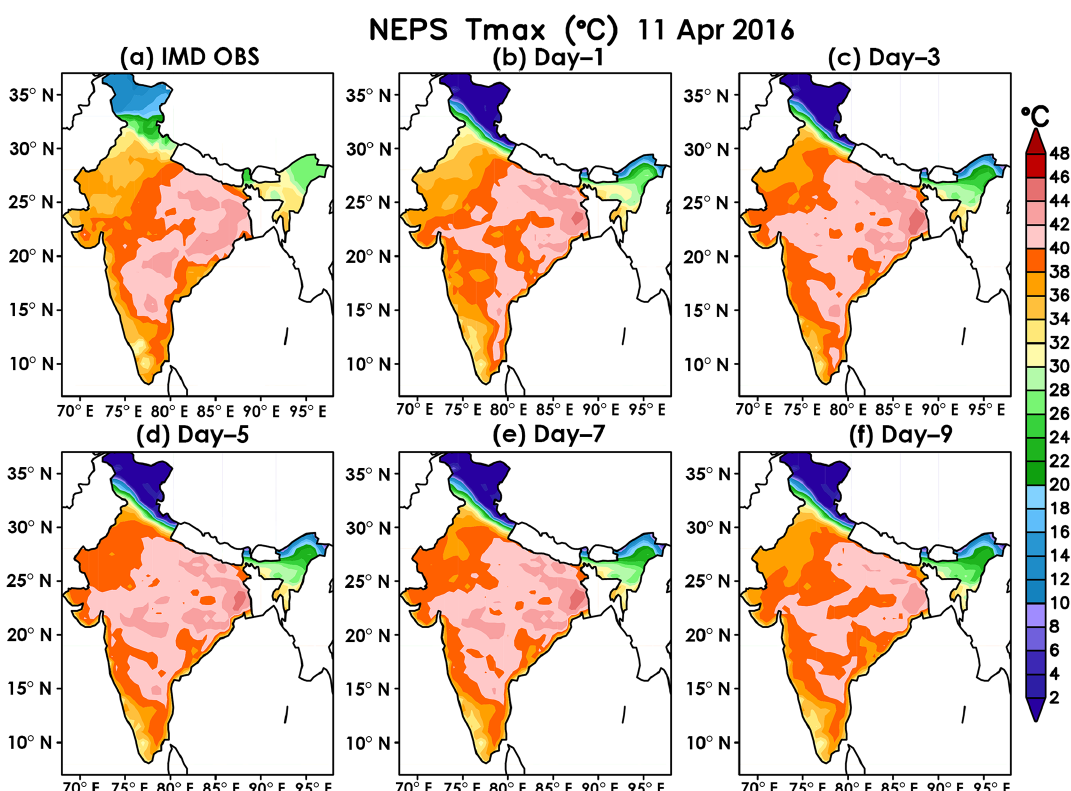
Figure 6. Spatial distributions of observed T max (a) and NEPS forecast T max (b–f) prevailing heatwaves over MP, Odisha, AP, Telangana and some parts of Maharashtra on 11 April 2016 (NEPS stands for NCMRWF ensemble prediction system; observed data from India Meteorological Department and forecast data from NCMRWF). Observed (a) T max ≥ 40 ◦ C is widespread over eastern India and a large part of the peninsula. NEPS forecasts (b–f) show a similar